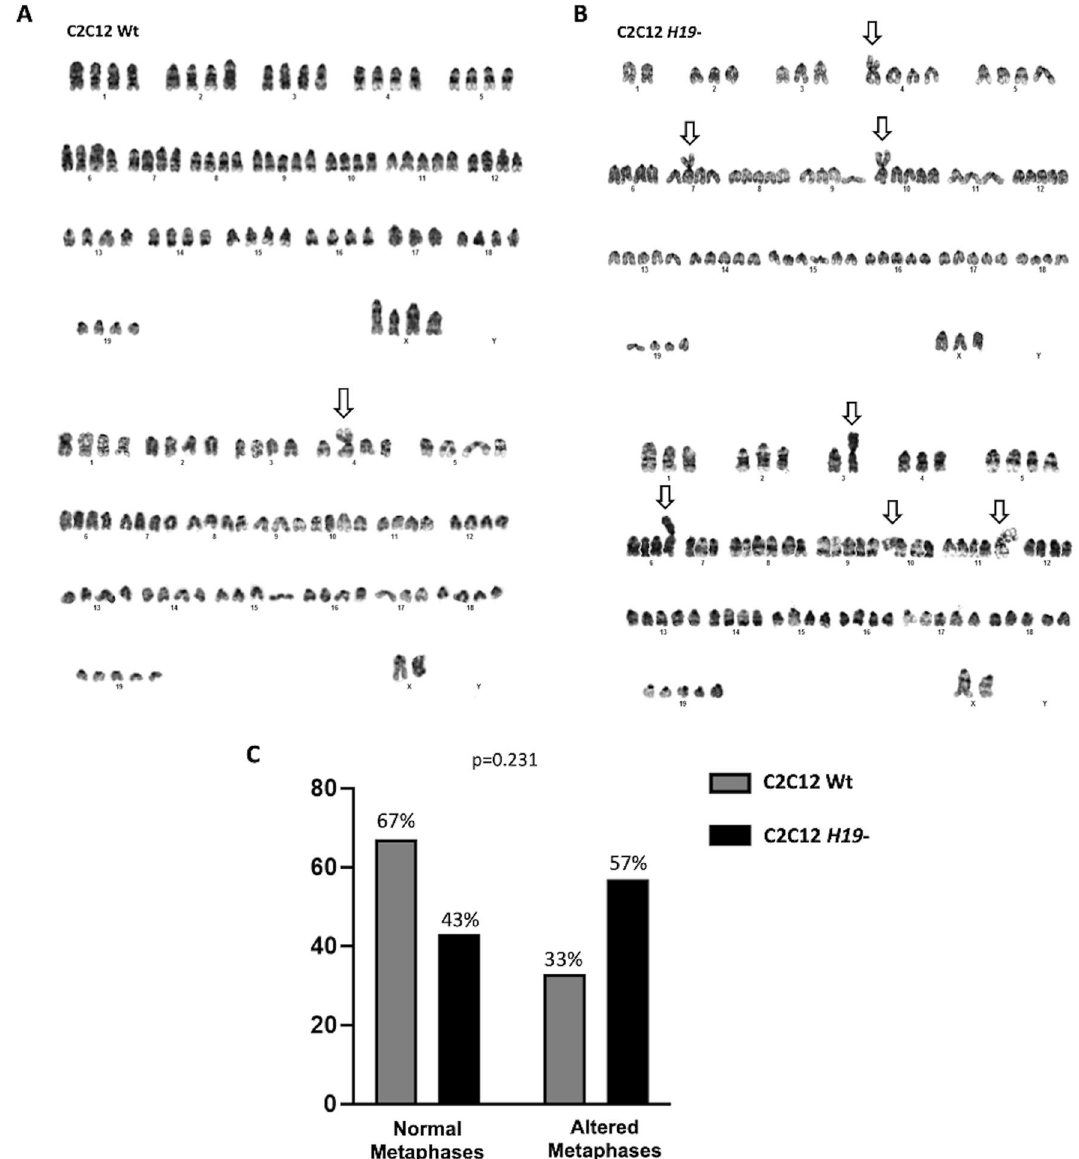
Figure 5. Karyotype analysis. C2C12 Wt ( A ) and C2C12 H19- colonies ( B ) showing chromosomal alterations, including increased translocations (arrow) in the knockdown cells. ( C ) Normal and altered metaphases in the C2C12 Wt and H19- cells ( p =